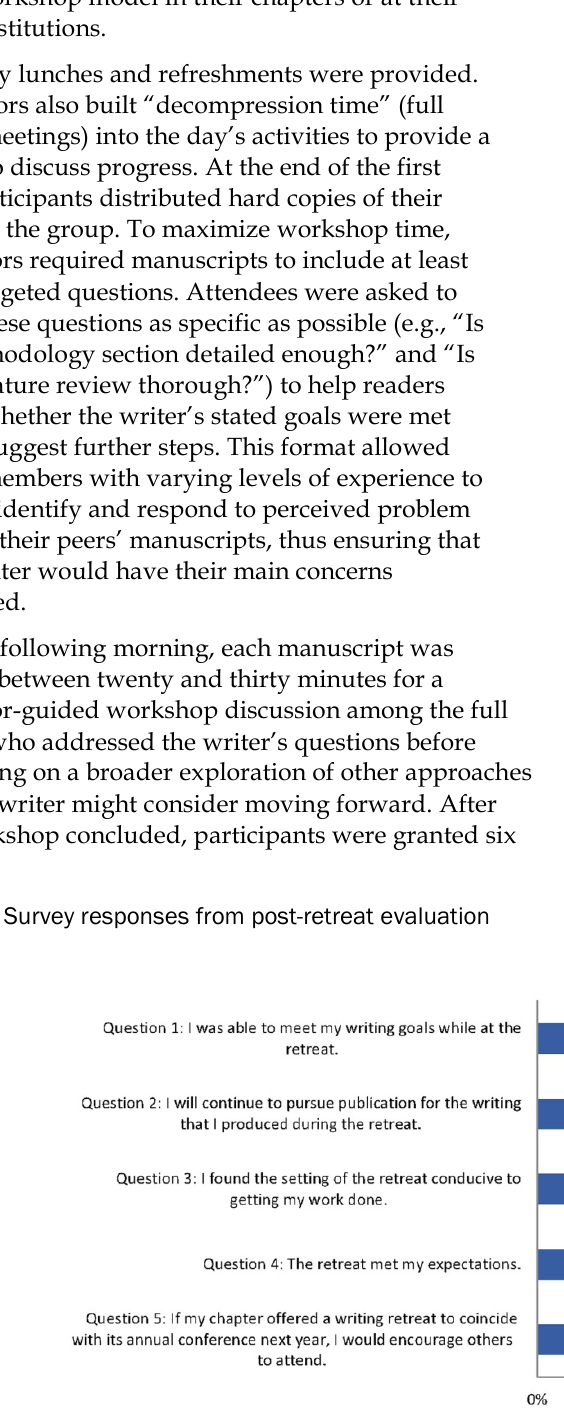
Attendees were asked to evaluate each statement using a scale of 1 (strongly disagree) to 5 (strongly